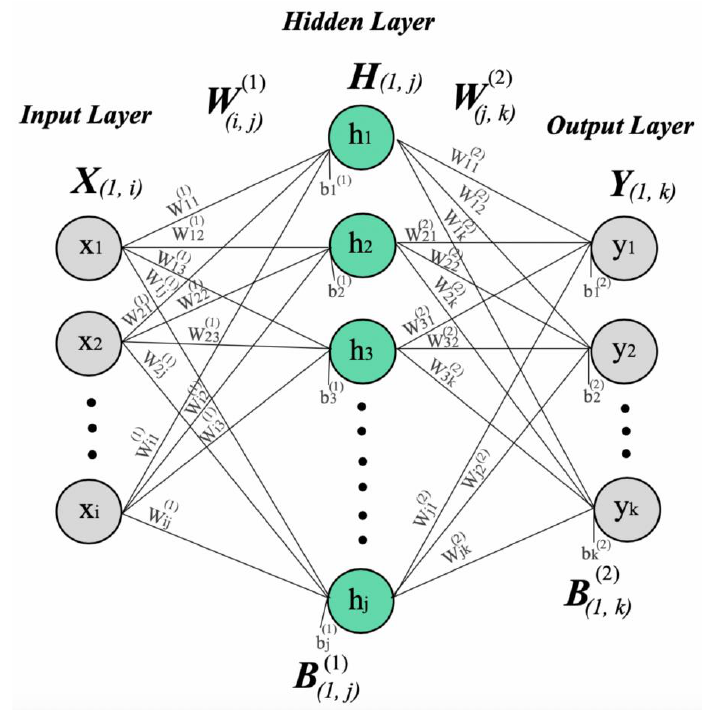
Figure 2. Concept of the artificial neural network.